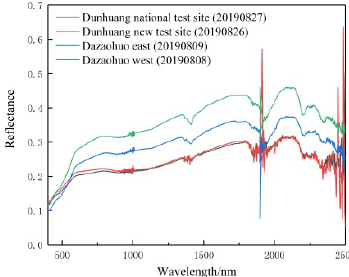
Figure 4. Measured spectral curves of each